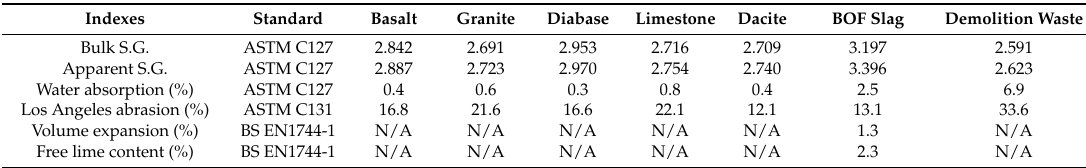
Table 2. Physical properties of different types of